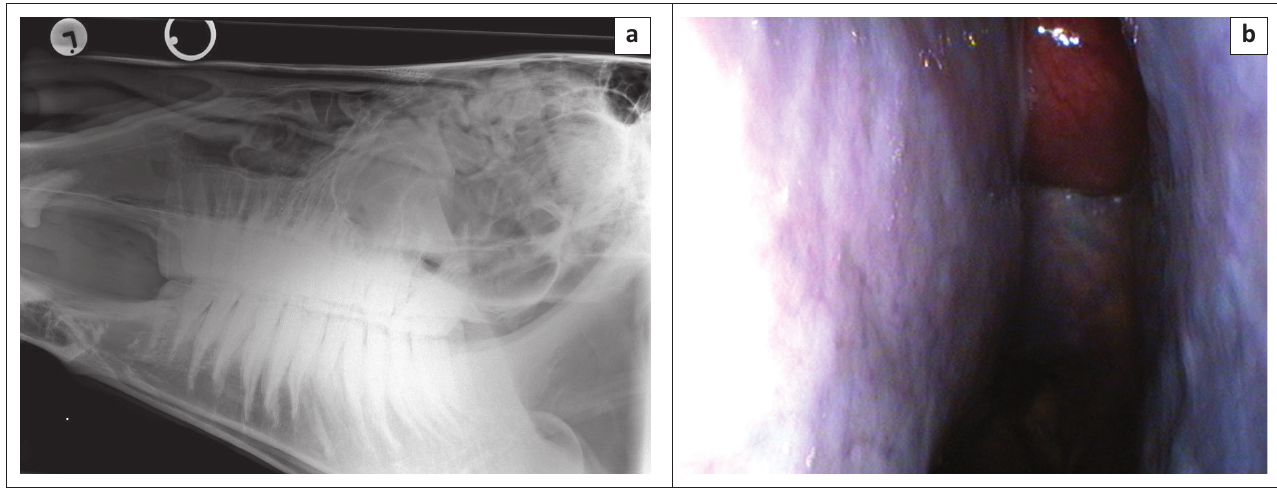
Source : Equine Clinic, University of Pretoria. FIGURE 1: Initial ancillary diagnostic examinations of a 13-year-old Thoroughbred gelding presented with a bilateral nasal discharge. (a) Lateral head radiographs. Note the well-circumscribed soft tissue masses situated in the dorsal conchal sinuses and the fluid lines present within the caudal maxillary sinuses. Additional soft tissue opacities are visible in the ethmoidal region. (b) Endoscopic view of the left middle meatus. Note the red round mass extending from the left ethmoid region rostrally into the nasal